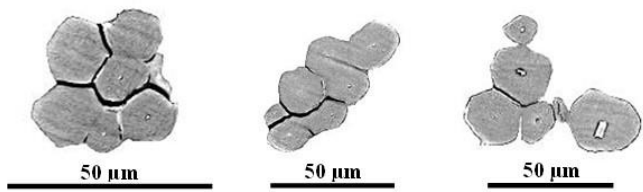
Figure 6. Examples of cross-sectional shape of flax technical fibres.